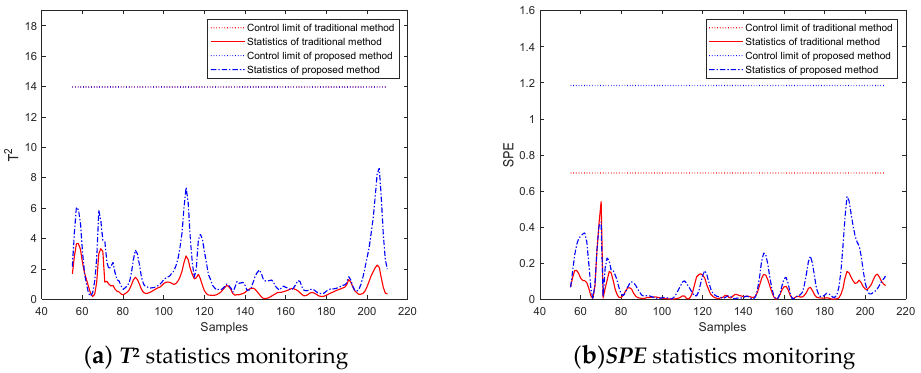
Figure 14. Multi-mode online monitoring of packing-holding phase of mode 3.